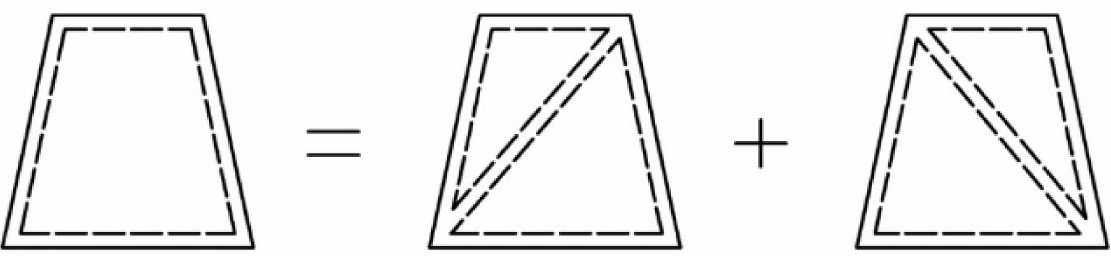
Figure 7. Diagram of applying wind load on 4-node elements.